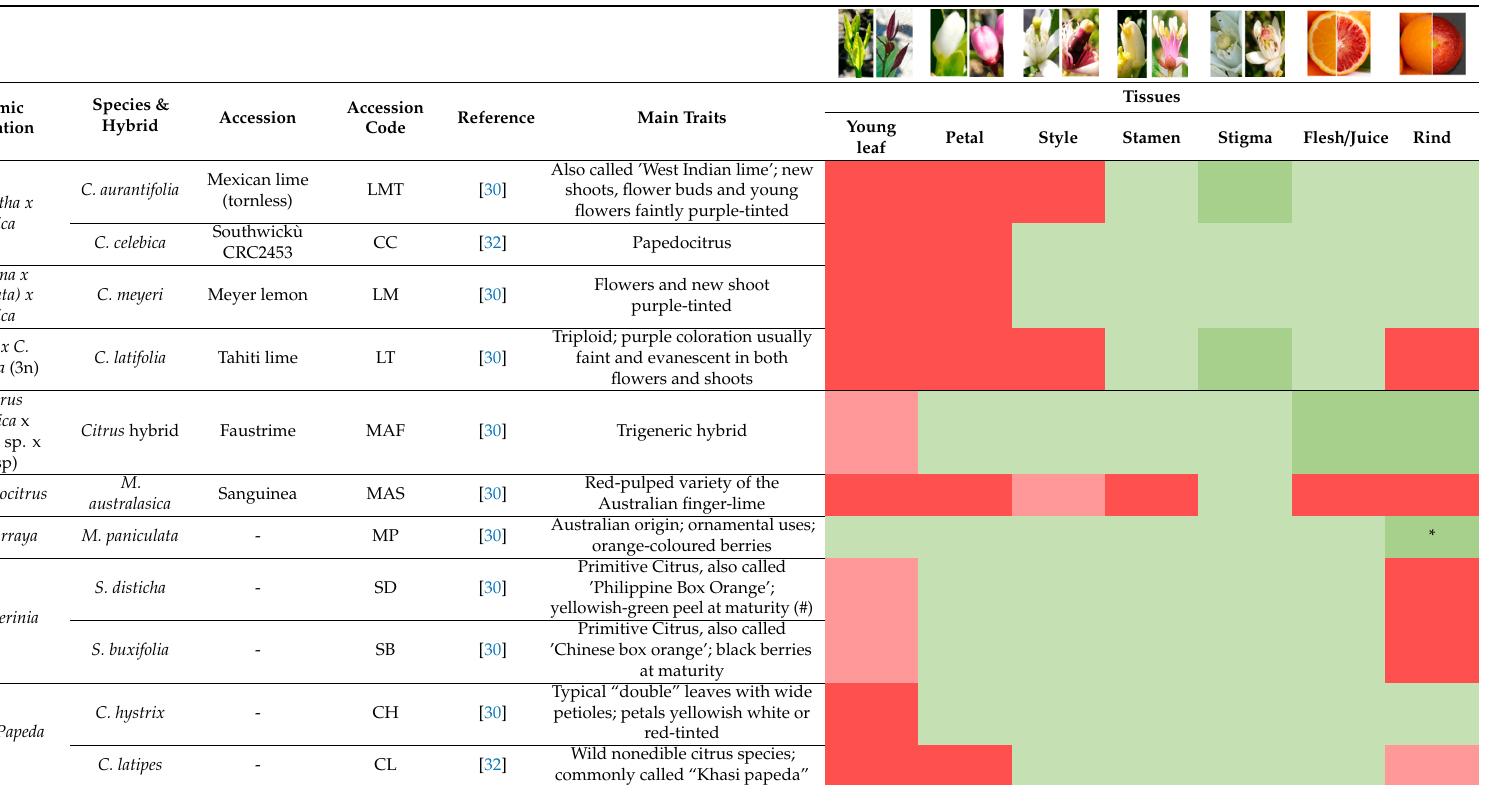
Table 1. Tissues and species evaluated in the study. The origins of the species and the hybrid for each accession are reported, as well as the accession code used in the qRT- PCR data, the references and the main traits characterizing each accession. Bright green boxes are used for negative controls, bright red boxes are used for anthocyanin- rich tissues. The corresponding light green and light red boxes refer to unpigmented and pigmented tissues collected for the expression analysis. Green boxes with asterisks refer to lycopene-rich tissues. # The pigmentation of S. disticha fruits could be due to the seedling origin of the accession located in the ‘Council for Agricultural Research and Economics’ bank germplasm.